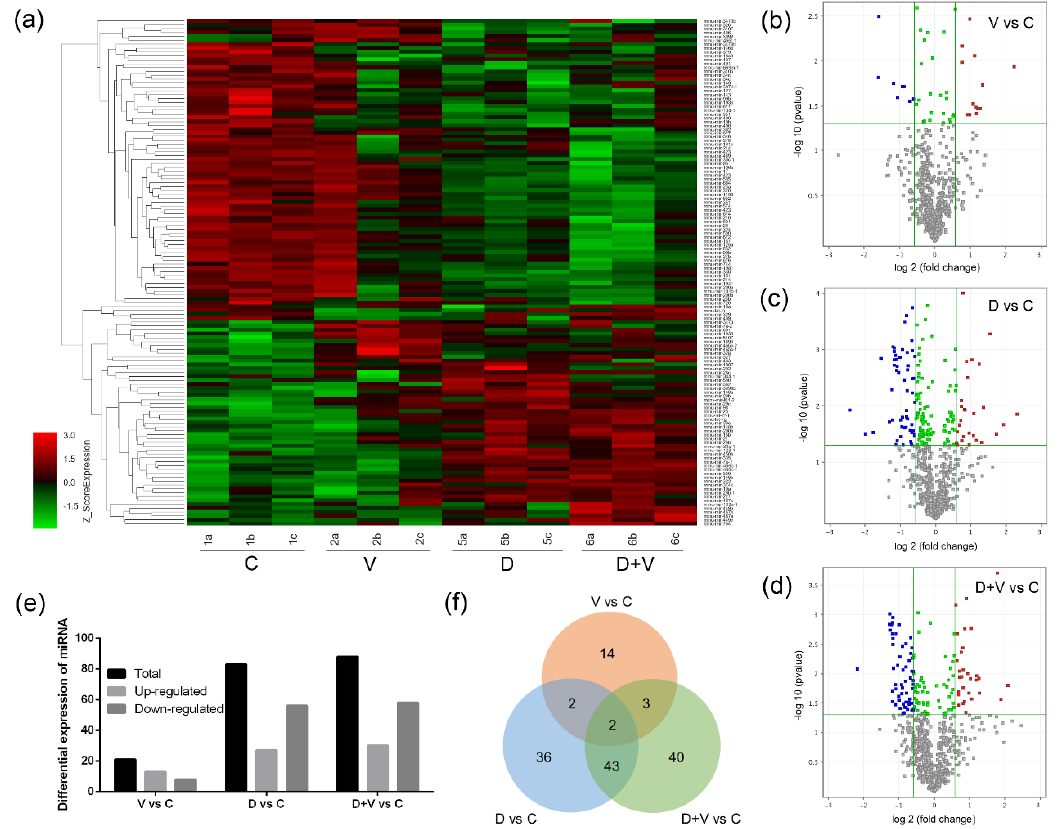
Figure 7. Changes in microRNA (miRNA) expression profiles as indicated by miRNA microarray analysis. ( a ) Heat map of the union of differentially expressed miRNAs between group V vs. C, group D vs. C, and group D + V vs. C. ( b ) Volcano plots of differentially expressed miRNAs between groups V and C. ( c ) Volcano plots of differentially expressed miRNAs between groups D and C. ( d ) Volcano plots of differentially expressed miRNAs between groups D + V and C. ( e ) Histogram of differential expression of miRNAs. ( f ) Venn chart of the intersection of differentially expressed miRNAs between group V vs. C, group D vs. C, and group D + V vs. C. In the Figure 7b–d, the blue dots represent the downregulated miRNA expression (fold change ≥ 1.5 and p ≤ 0.05), and the red dots represent the upregulated miRNA expression (fold change ≥ 1.5 and p ≤ 0.05). The grey dots have no statistical significance ( p > 0.05). The green dots show a not obvious difference (fold change < 1.5 and p < 0.05).